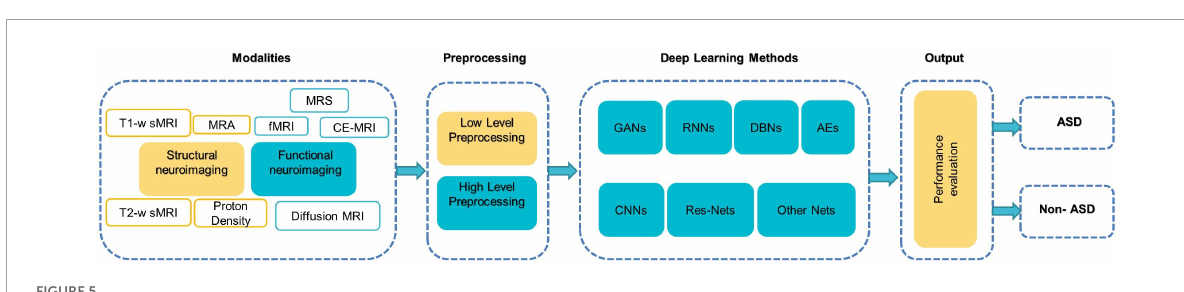
FIGURE5 The components of typical DL-based methods for diagnosing ASD (Khodatars et al.,